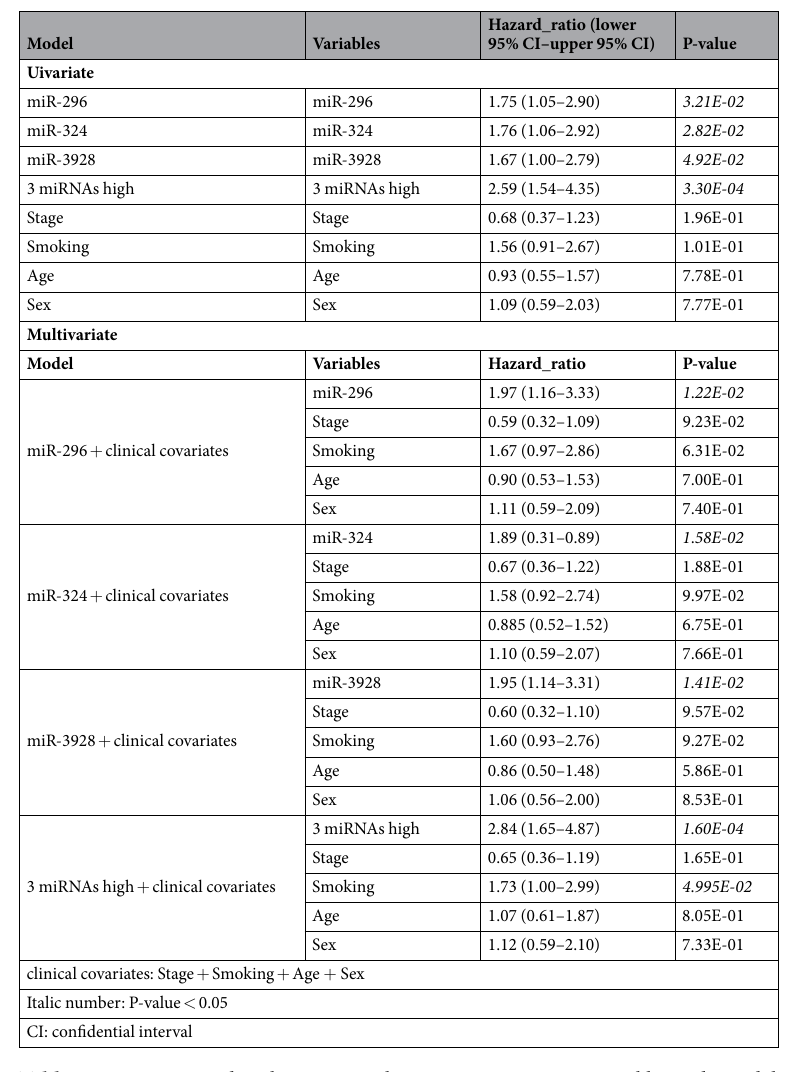
Table 2. Univariate and multivariate analyses using Cox proportional hazards models. Univariate and Multivariate analysis